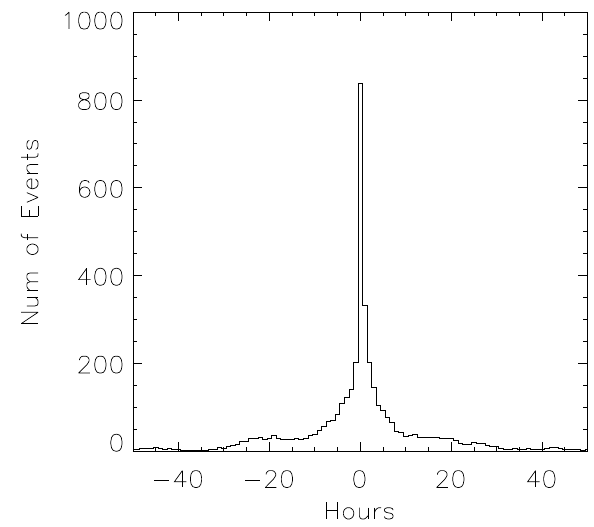
Fig. 1. Histogram of minimum time differences between each of our 2380 events and those discussed in Anderson et al.